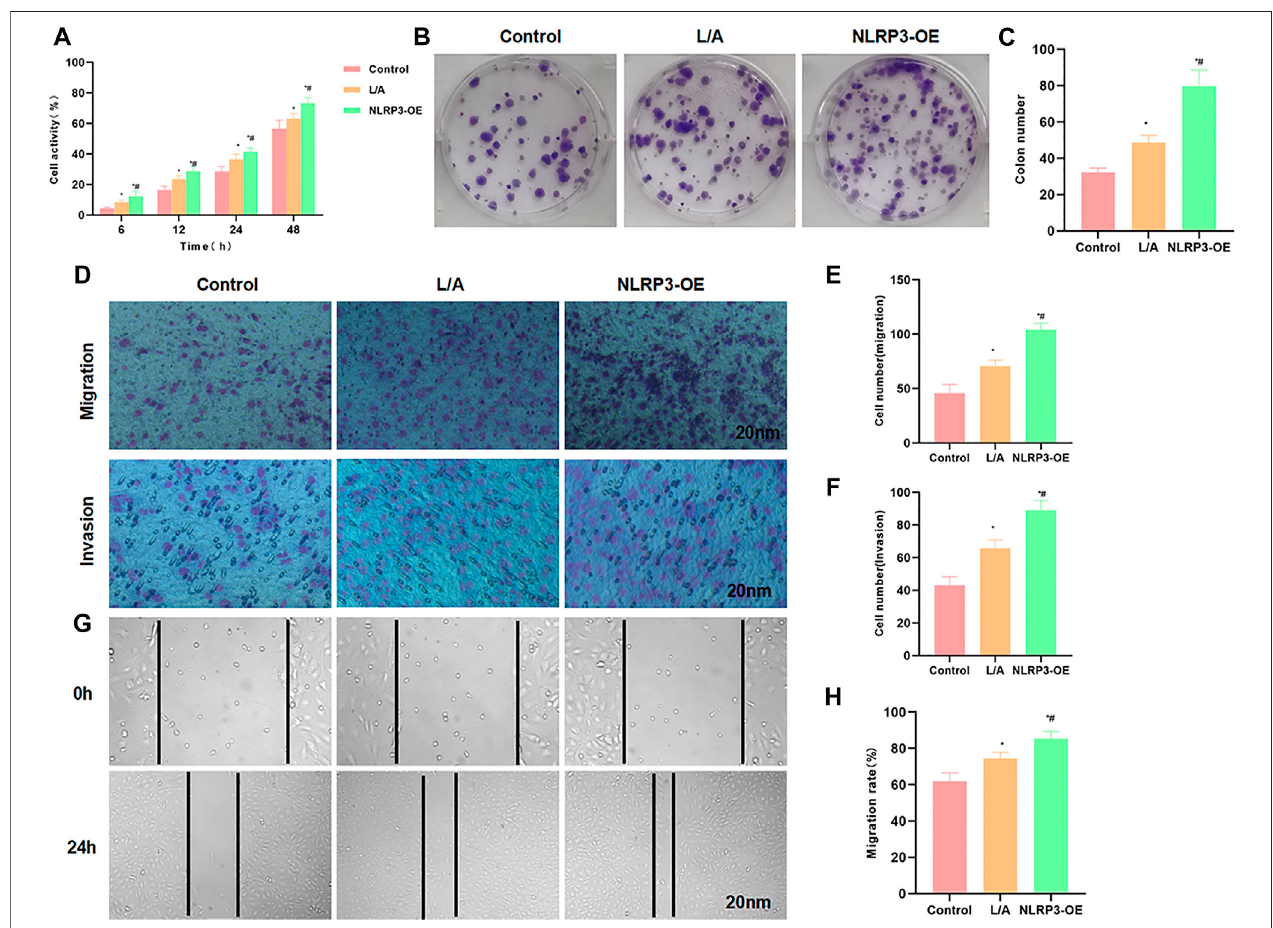
FIGURE 1 | NLRP3 promoted the malignant behavior of SW480 in the in fl ammatory microenvironment. (A) : The detection of cell viability revealed that cell viability wassigni fi cantly upregulated in the in fl ammatorymicroenvironment. NLRP3 overexpression could further promote cell viability. Comparison with the control group, * p < 0.05;comparisonwiththeL/Agroup, # p < 0.05. (B,C) :ColonyformationassayshowedthatLPS/ATPinducedcolonyformationinSW480,withmorenumberofcolonies than that of control. Overexpression of NLRP3 could further promote colony formation. Statistical analysis of the number of colonies, comparison with the control group, * p < 0.05; Comparison with the L/A group, # p < 0.05. (D – F) : Detection of cell invasion and migration by Transwell assay revealed that NLRP3 could promote the migrationandinvasionabilityofSW480inthein fl ammatorymicroenvironment. Comparison withthecontrolgroup, * p < 0.05;comparison withtheL/Agroup, # p < 0.05. (G,H) : Wound healing assay showed that NLRP3 could promote the migration of SW480 cells. Analysis of the migration rate, comparison with the Control group, * p < 0.05; comparison with the L/A group, # p <